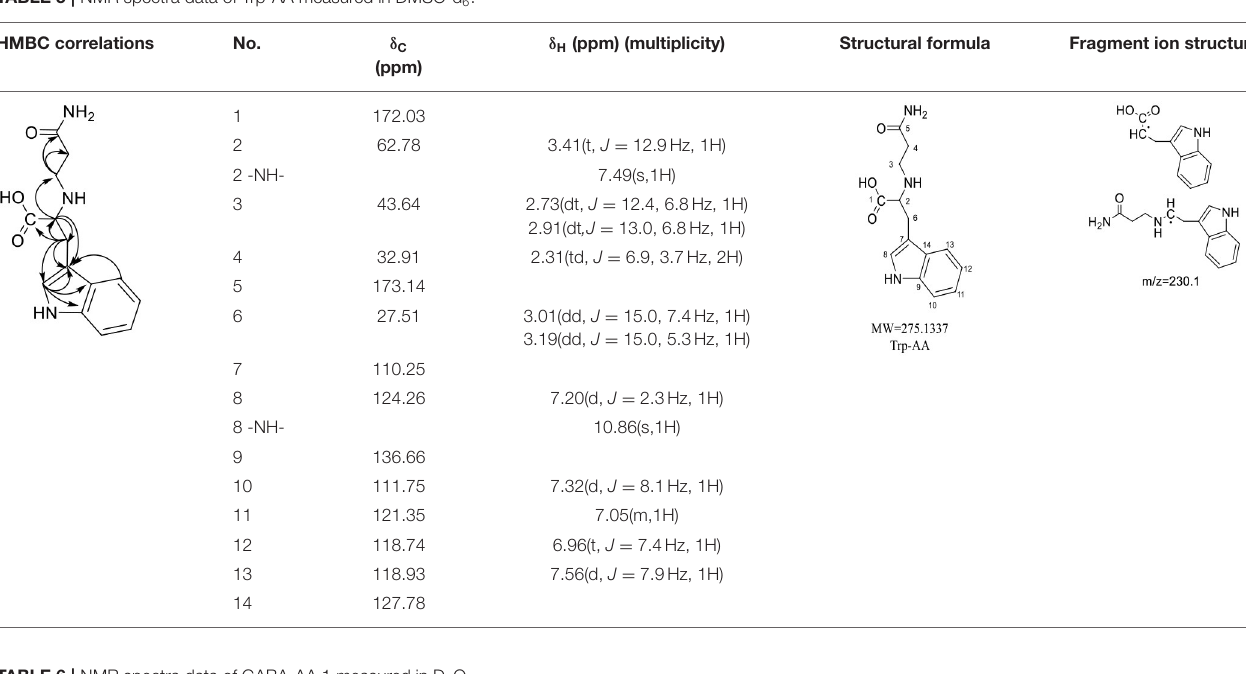
TABLE 6 | NMR spectra data of GABA-AA 1 measured in D 2 O. HMBC